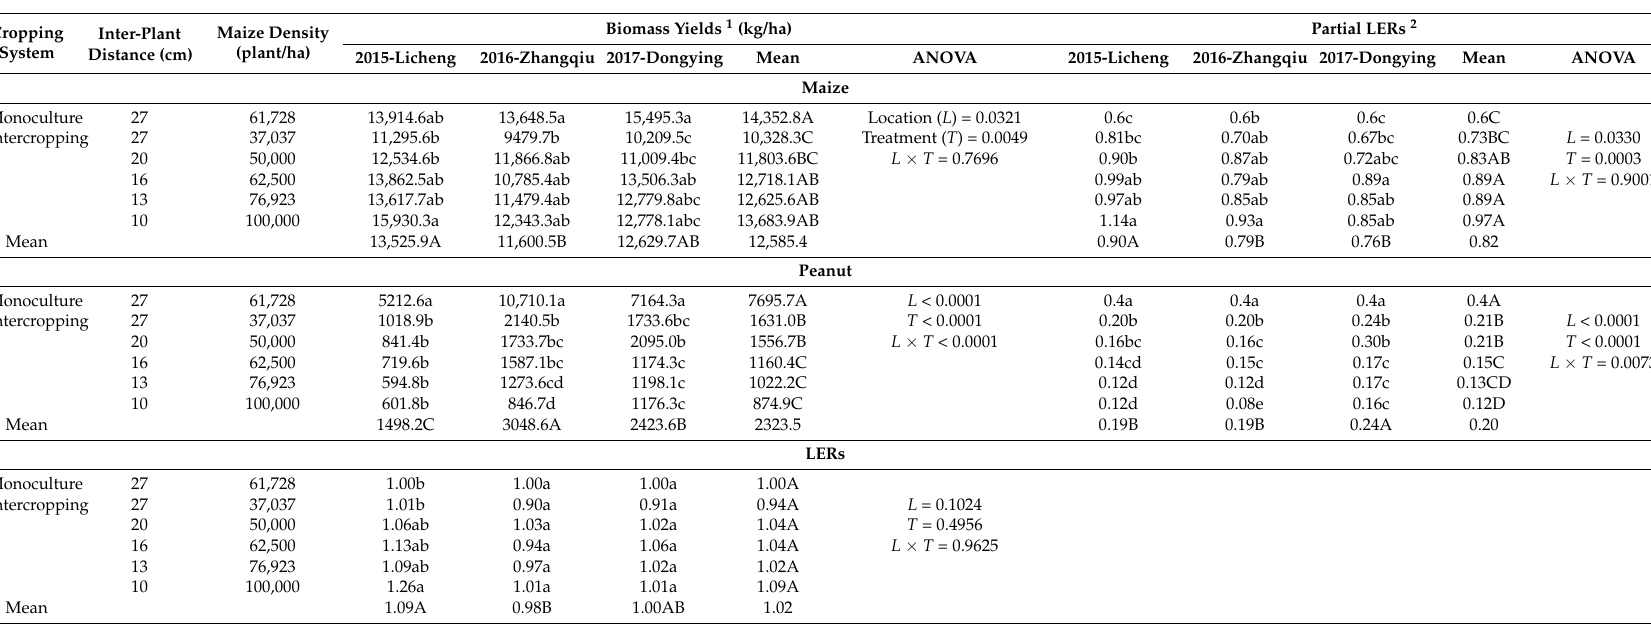
Table 4. Biomass yields and partial land equivalent ratios (LERs) of maize and peanut and corresponding LERs of the whole intercropping system as affected by different cropping systems and maize densities across different